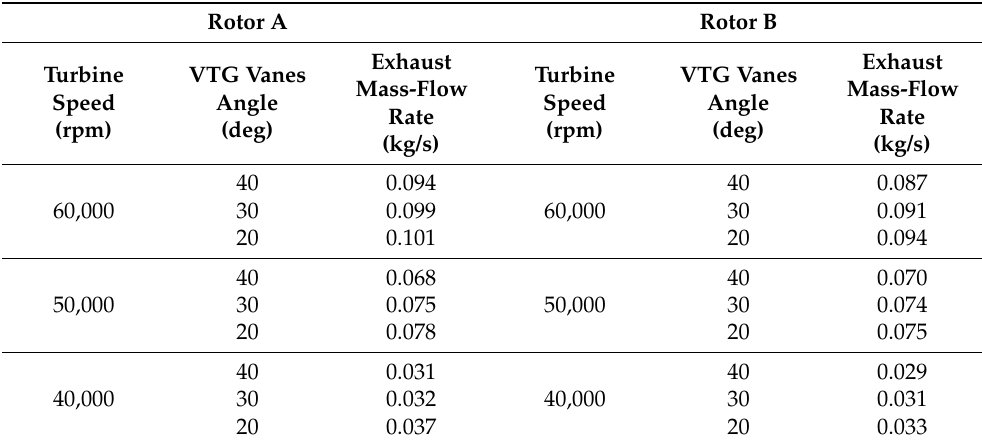
Figure 20. The changes of exhaust mass flow rate at the rotor gap interface for three different turbine speeds, VTG vane positions and rotor geometries ( a ) rotor B at 60,000 rpm, ( b ) rotor A at 60,000 rpm, ( c ) rotor B at 50,000 rpm, ( d ) rotor A at 50,000 rpm, ( e ) rotor B at 40,000 rpm, ( f ) rotor A at 40,000 rpm. Table 7. The total leakage values of the exhaust gases’ mass-flow rate though the rotor gaps during the single revolution of the